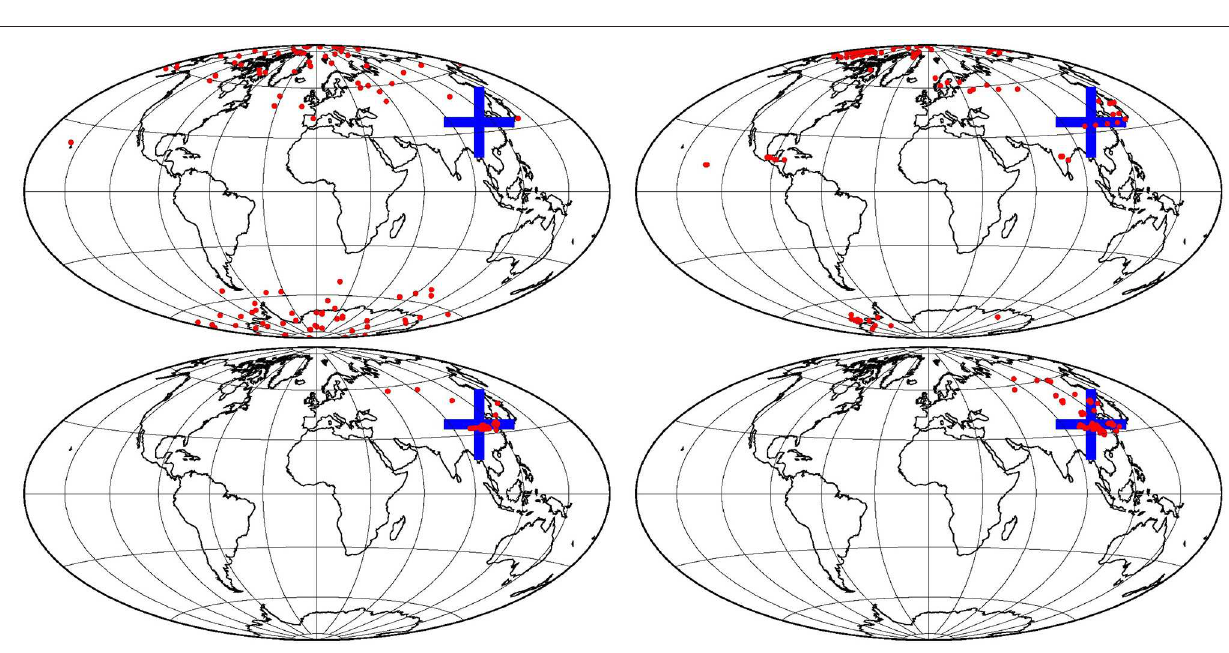
FIGURE 11 | Distribution of the location of the maximum, as obtained: from the prior ensemble (top left) , from the updated ensemble using the local observations only (top right) , from the updated ensemble using all observations (bottom left) , and from the updated ensemble using observation y o b only (bottom right) .